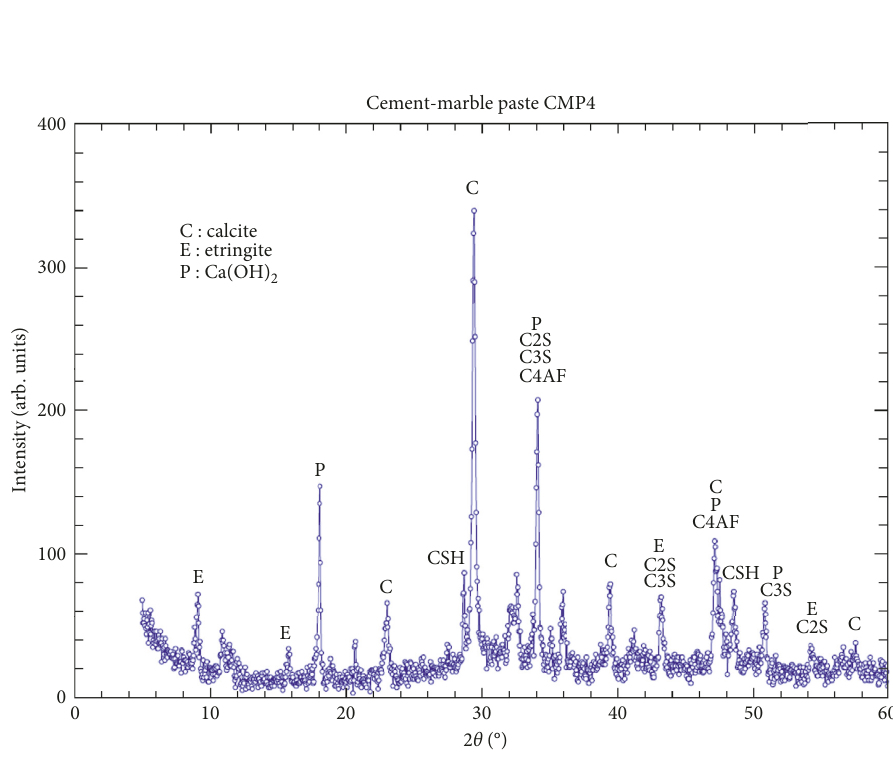
Figure 14: X-ray diffraction pattern of paste